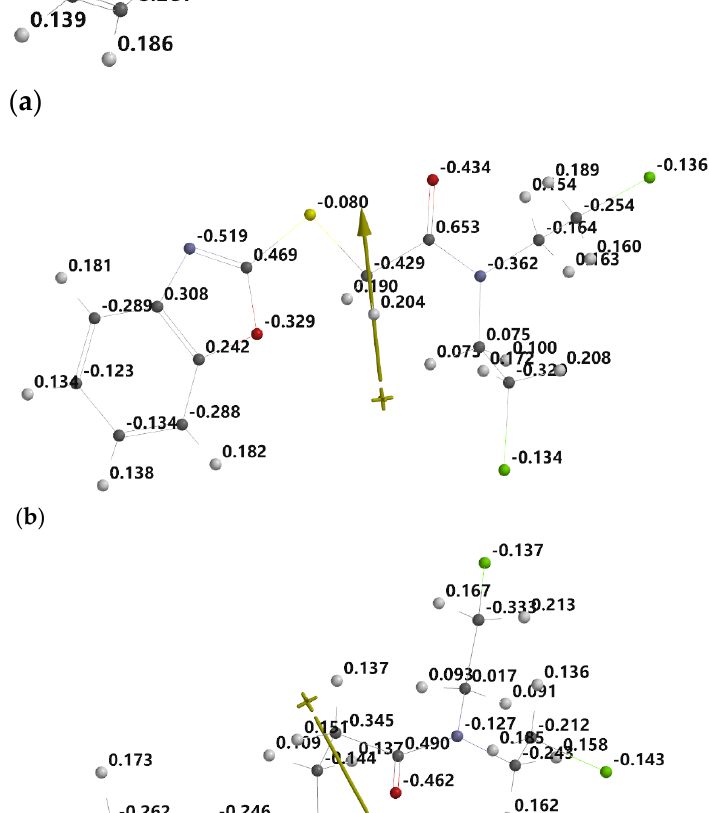
Figure 9. Electrostatic charges near the atoms composing the structures of molecules VIII ( a ), IX ( b ), and X ( c ), respectively.